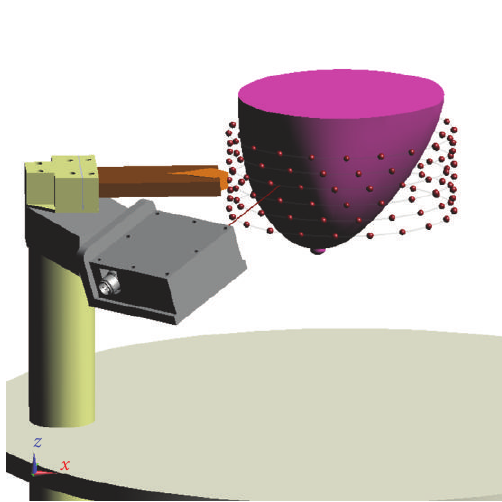
Figure 3: View of the scan pattern used for measurement. Each sphere corresponds to an antenna location. Antennas located on a common row are connected by